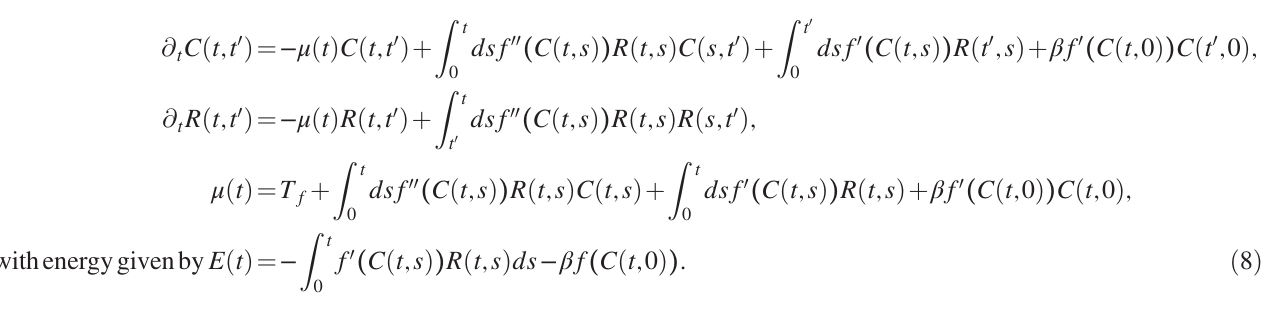
ffiffiffiffiffiffiffiffiffiffiffi p f 00 ð 1 Þ